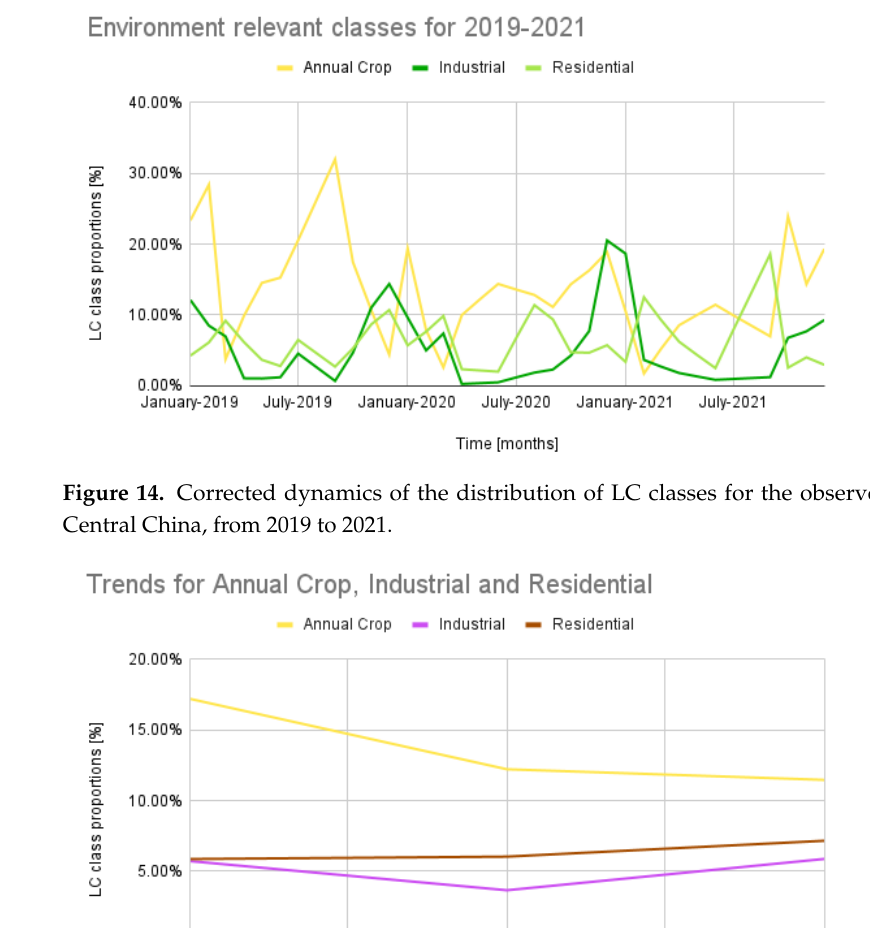
Figure 13. Dynamics of the distribution of LC classes for CER region in China, from 2019 to 2021.